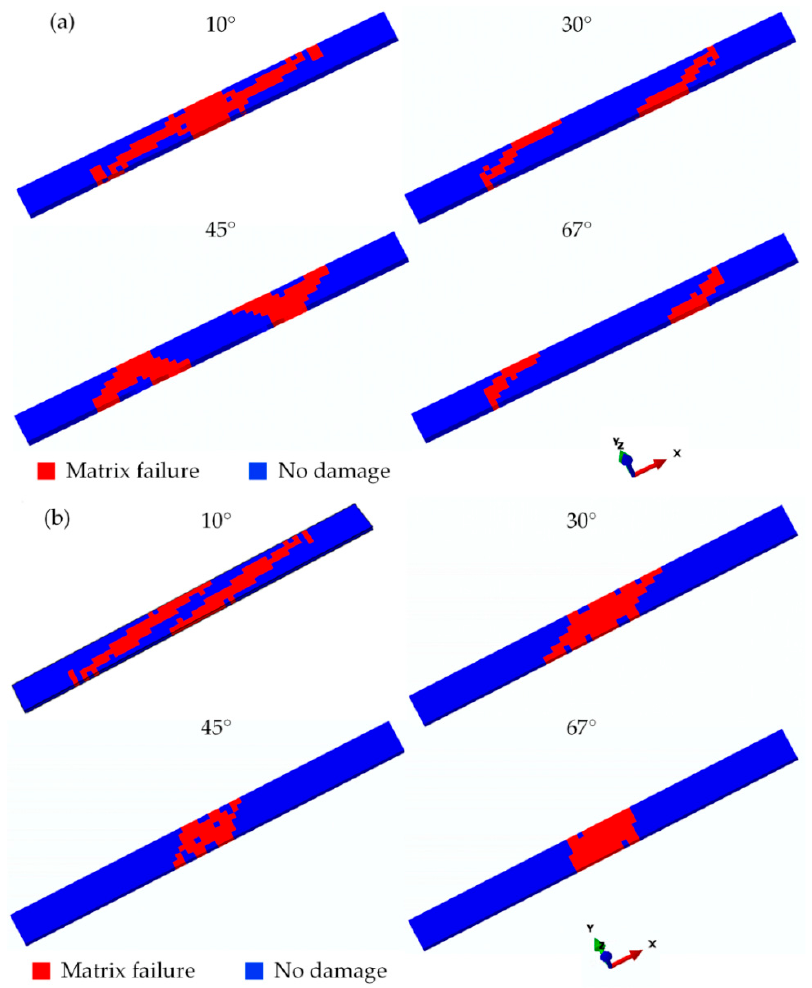
Figure 5. Failure modes in the simulations: ( a ) Off-axis tension; ( b ) Off-axis compression. Table 3. Strength of unidirectional laminates T300/5228A under off-axis loading.